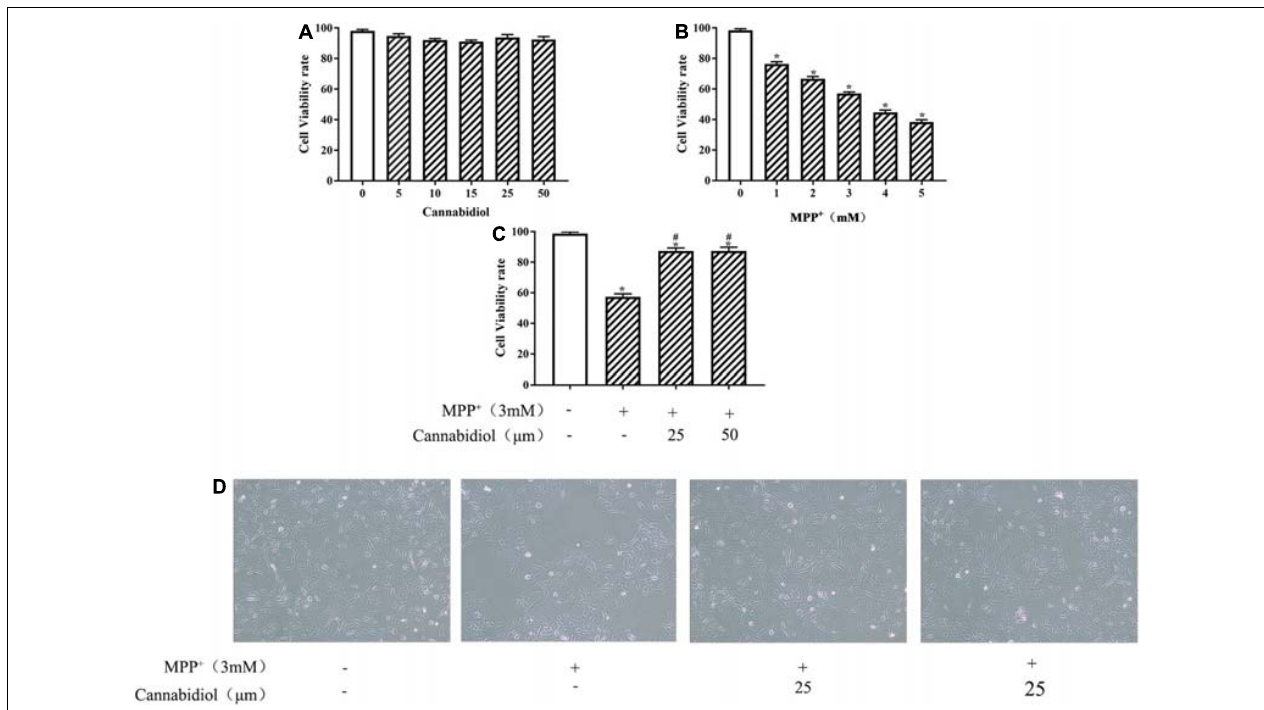
FIGURE 1 | Cannabidiol protected SH-SY5Y cells against MPP + -induced cytotoxicity and Loss of Tyrosine Hydroxylase (TH) expression. (A–C) SH-SY5Y cells were treated with different concentrations of Cannabidiol or MPP + for 24 h and Cells viability was measured by the 3-(4,5-dimethylthiazol-2-yl)-2,5-diphenyltetrazolium bromide (MTT) assay. (D) Cells viability was Observed by Microscopic (100 × ); The expression of TH in SH-SY5Y cells were measured by western blotting; * p < 0.05, compared with control group, # p < 0.05 compared with MPP+ alone.